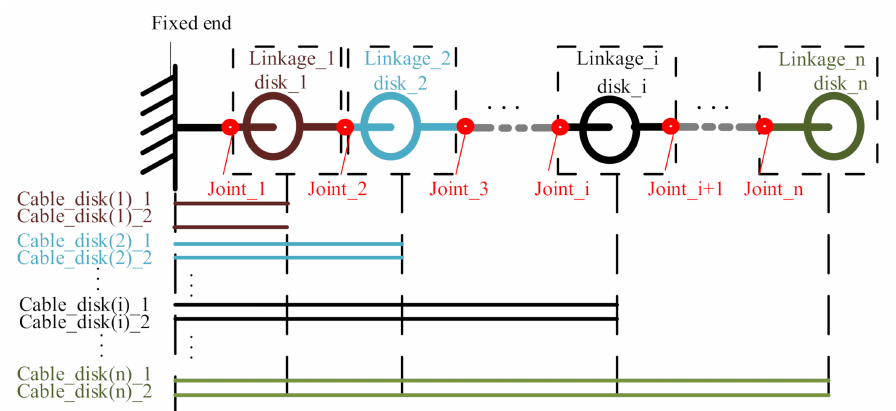
Figure 1. The degree of freedom ( n -DOF) planar cable-driven serpentine manipulator (CDSM) (driven by m cables, m = 2 n ).